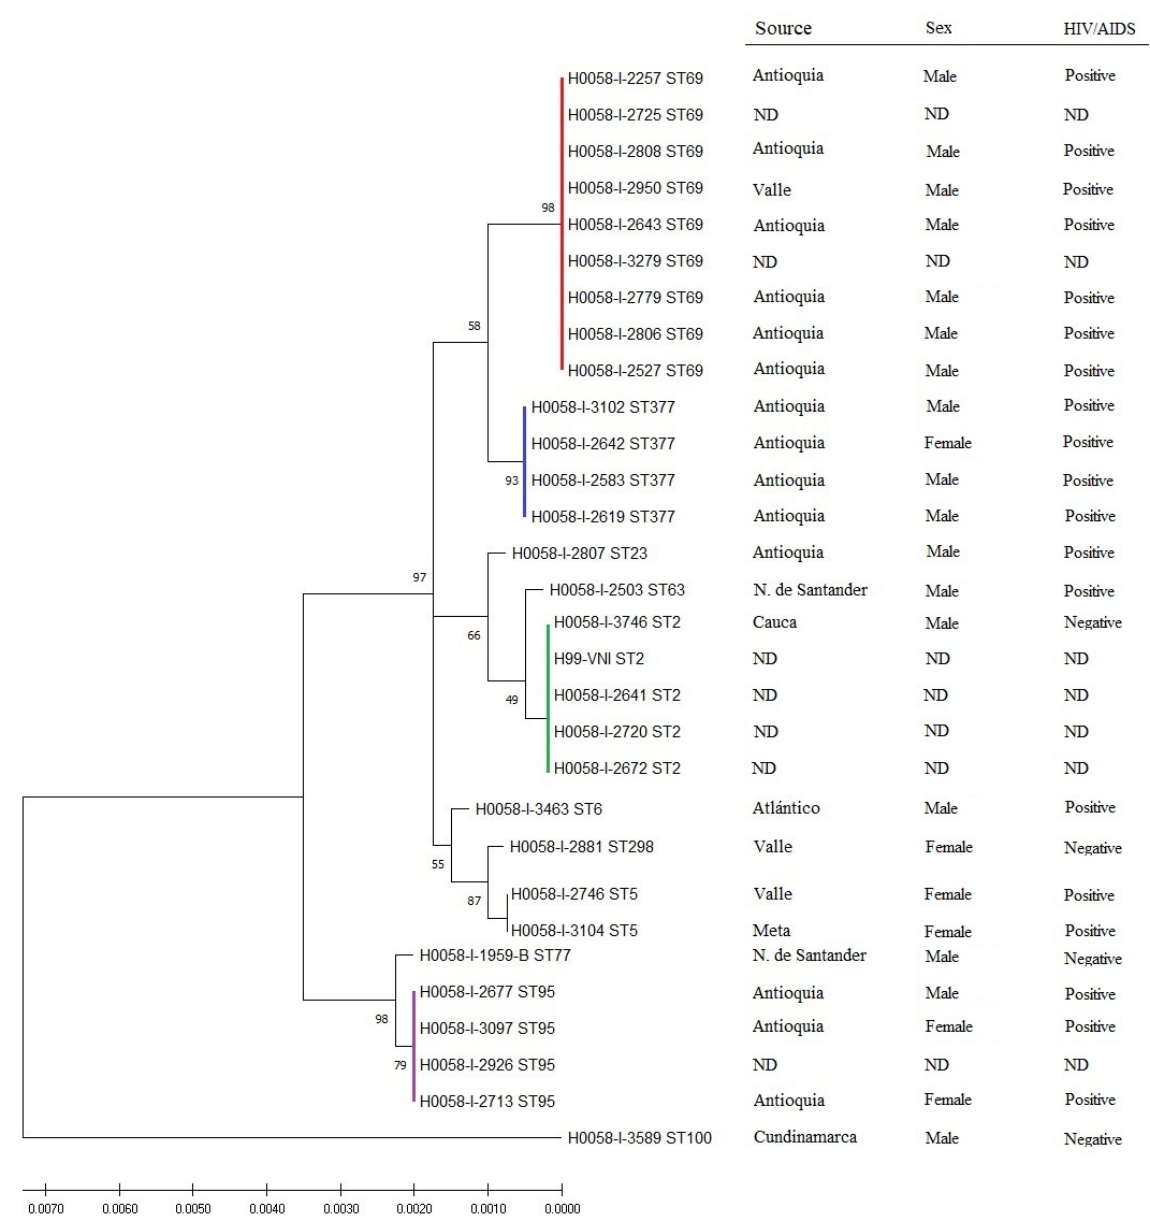
Figure 1. Hierarchical grouping of the 29 clinical isolates of C. neoformans var. grubii based on the MLST allelic profile. The figure shows the relationship among the STs of the clinical isolates. The evolutionary history, as inferred from the MLST data, was reconstructed via the maximum likelihood method and the Jukes–Cantor model using concatenated nucleotide sequences of 7 loci. Bootstrap values are displayed for each branch (1000 repeats). Representative clinical variables are listed on the right of the image. The most frequent sequence types are highlighted in colors. ND: no data.